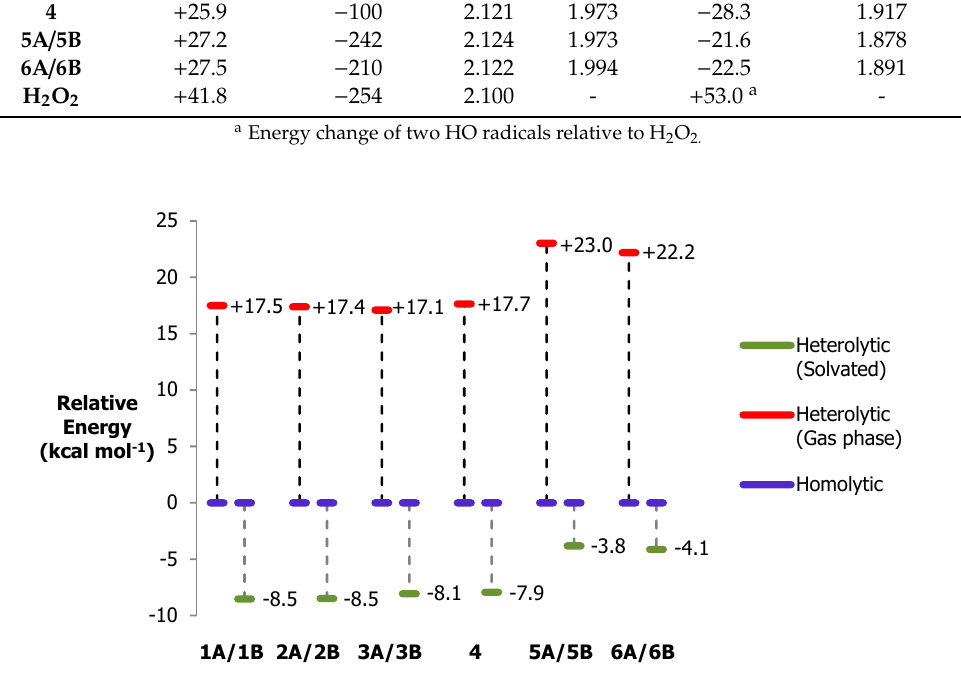
Figure 6. Relative stabilities of [(L)Ni 2 + –O · ] + HS (homolytic) and [(L)Ni 3 + –O · ] 2 + HS (heterolytic) intermediates. Calculated energies in the gas phase are reflected in × 10 kcal mol − 1 units.